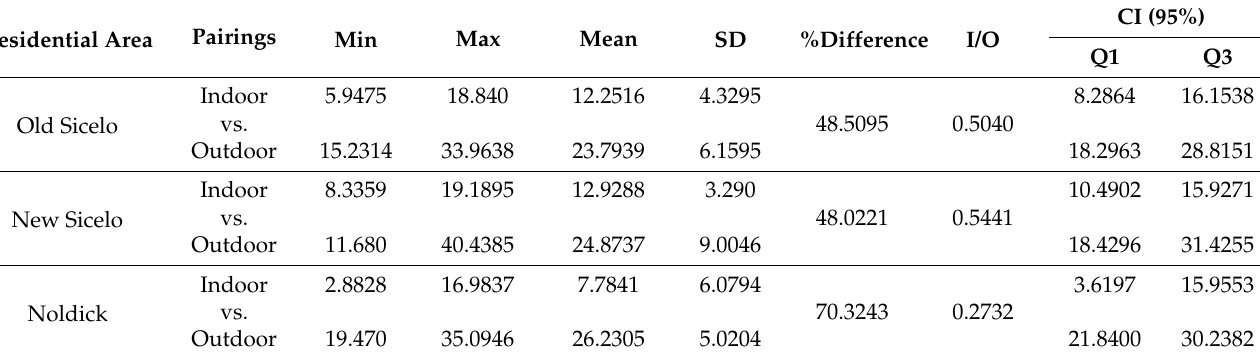
Table 1. Descriptive statistics of indoor and outdoor PM 2.5 mass concentrations ( µ g/m 3 ) and indoor–outdoor ratios in the three residential areas.